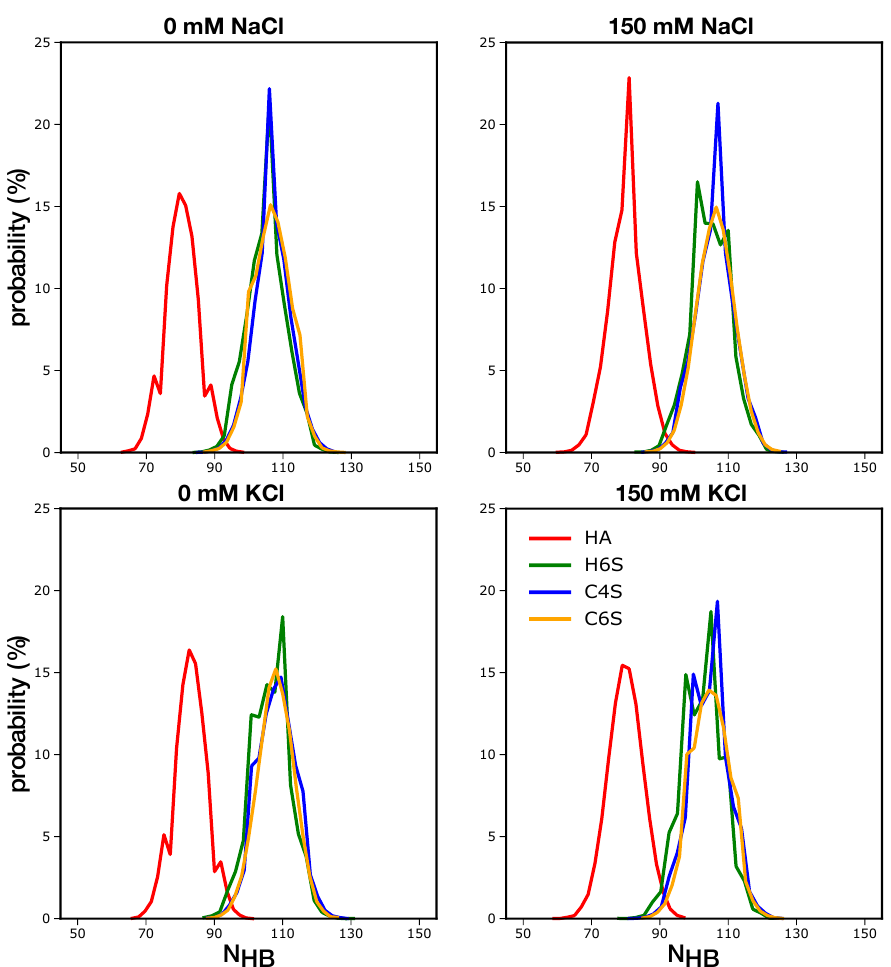
Figure 6. Distribution of the number of H-bonds formed between water molecules and the different GAGs (see the color key) at the 0 mM ( left ) and 150 mM ( right ) salt concentrations (see the label above each